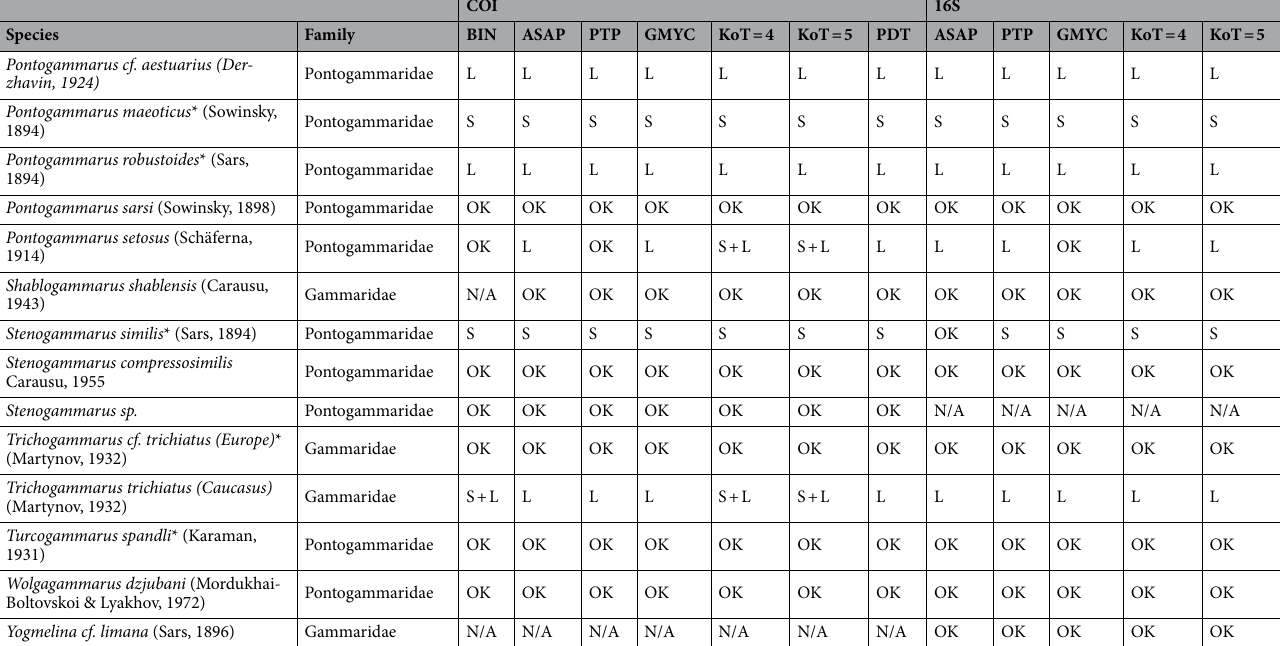
Table 1. Overview of the 57 species which were studied and their morpho-molecular congruence. Asterisks denote species that have been sequenced in both this study and previously. Daggers indicate species for which sequences were available only from the literature. The remaining species were sequenced for the first time in this study. OK morpho-molecular congruence, L lumped, S